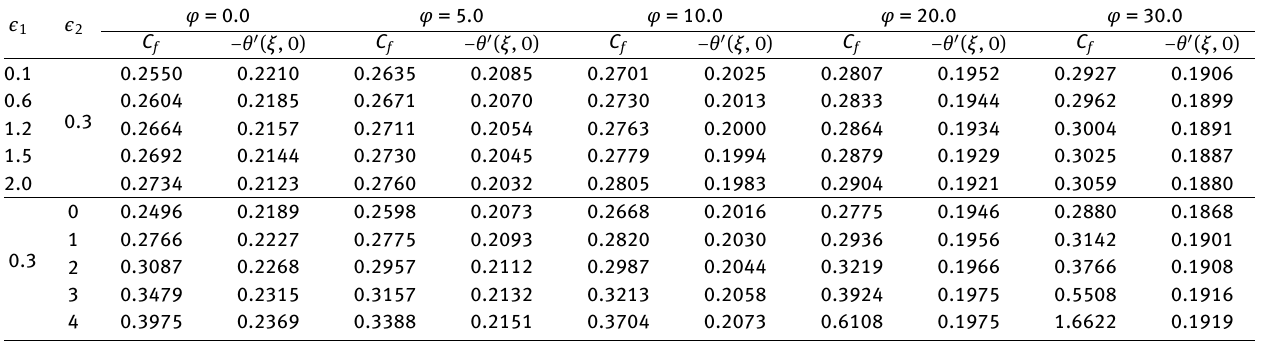
Table 2: Values of C f and − θ (cid:48) ( ξ , 0) for different φ , ϵ 1 and ϵ 2 ( Pr = 7.0, F = 0.5, γ = 0.2, ξ = 1.0)